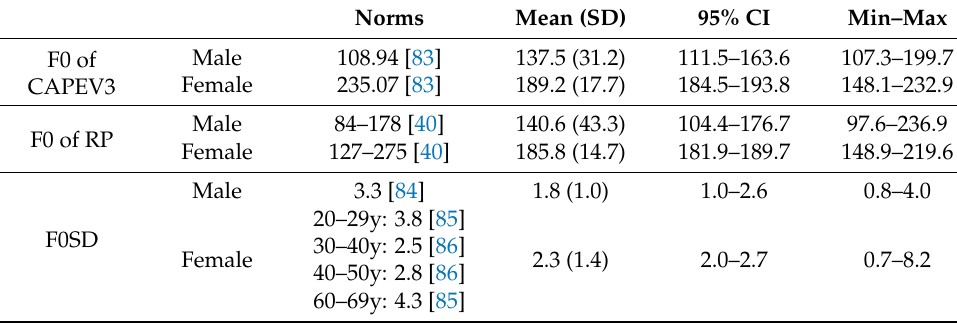
Table 5. Fundamental frequency data (Hz) of the cohort at baseline ( n = 68).